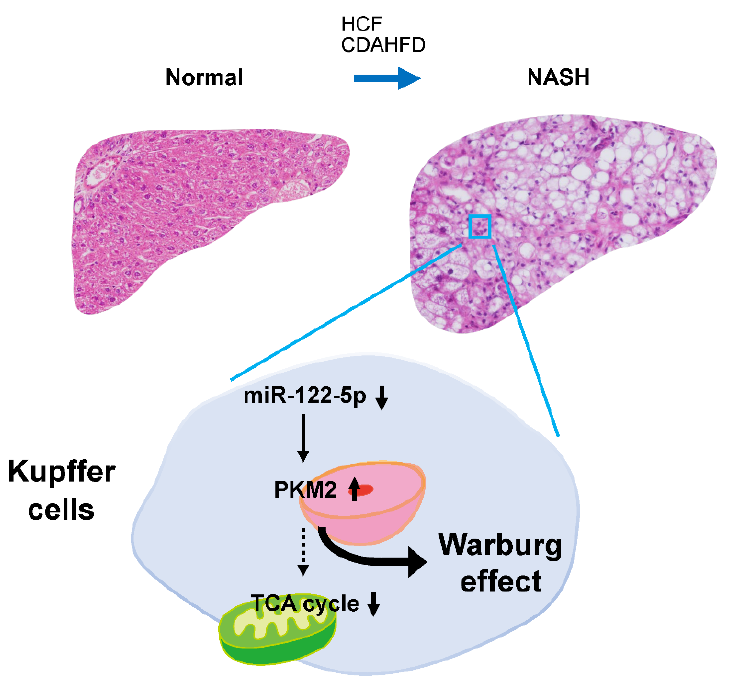
Figure 6. Schematic diagram of the miR-122-5p-mediated regulation of the Warburg effect in Kupffer cells during non-alcoholic steatohepatitis (NASH). The Warburg effect, particularly glycolysis, was activated in animal models of NASH. One of the main mechanisms underlying this activation was the upregulation of PKM2. Notably, dysregulation of miR-122-5p partially induced PKM2 upregulation, especially in Kupffer cells during NASH. These findings suggest that miRNA is strongly related to metabolic changes in carcinogenesis, even during the precancerous phase.